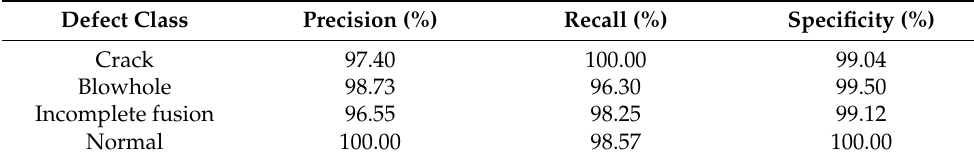
Figure 11. Testing result of the model in this study. Table 4. Model performance evaluation metrics for each defect class.